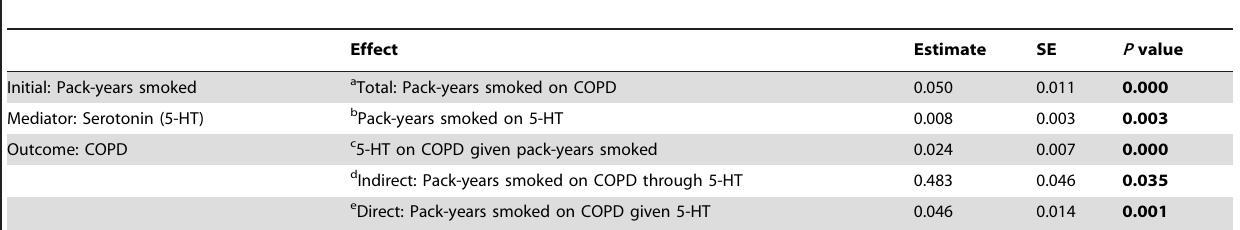
Table 3. Mediation effects of 5-HT on the relation between pack-years smoked and